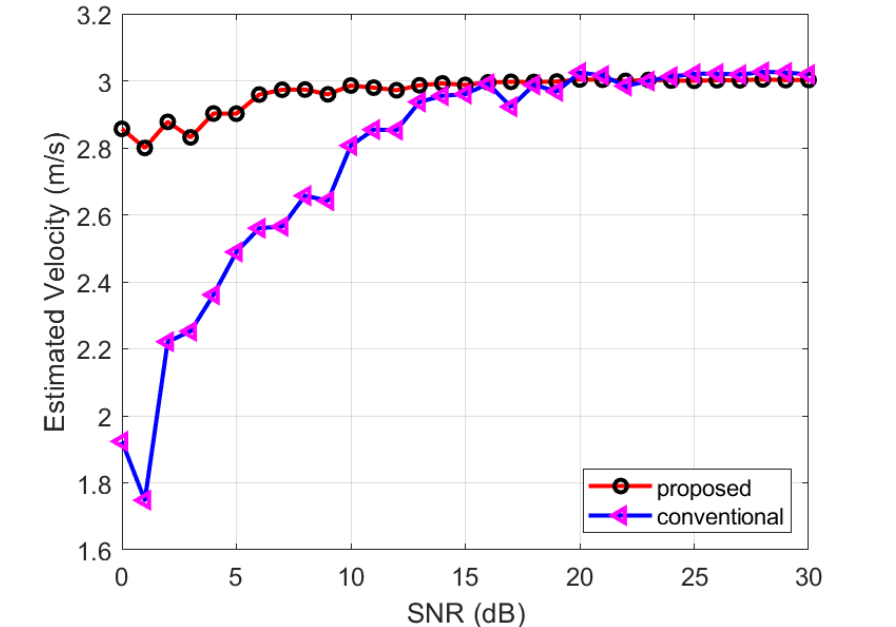
Figure 5. Performance comparison between the proposed signal and the convention signal under in-band SNR from 0 to 30 dB.